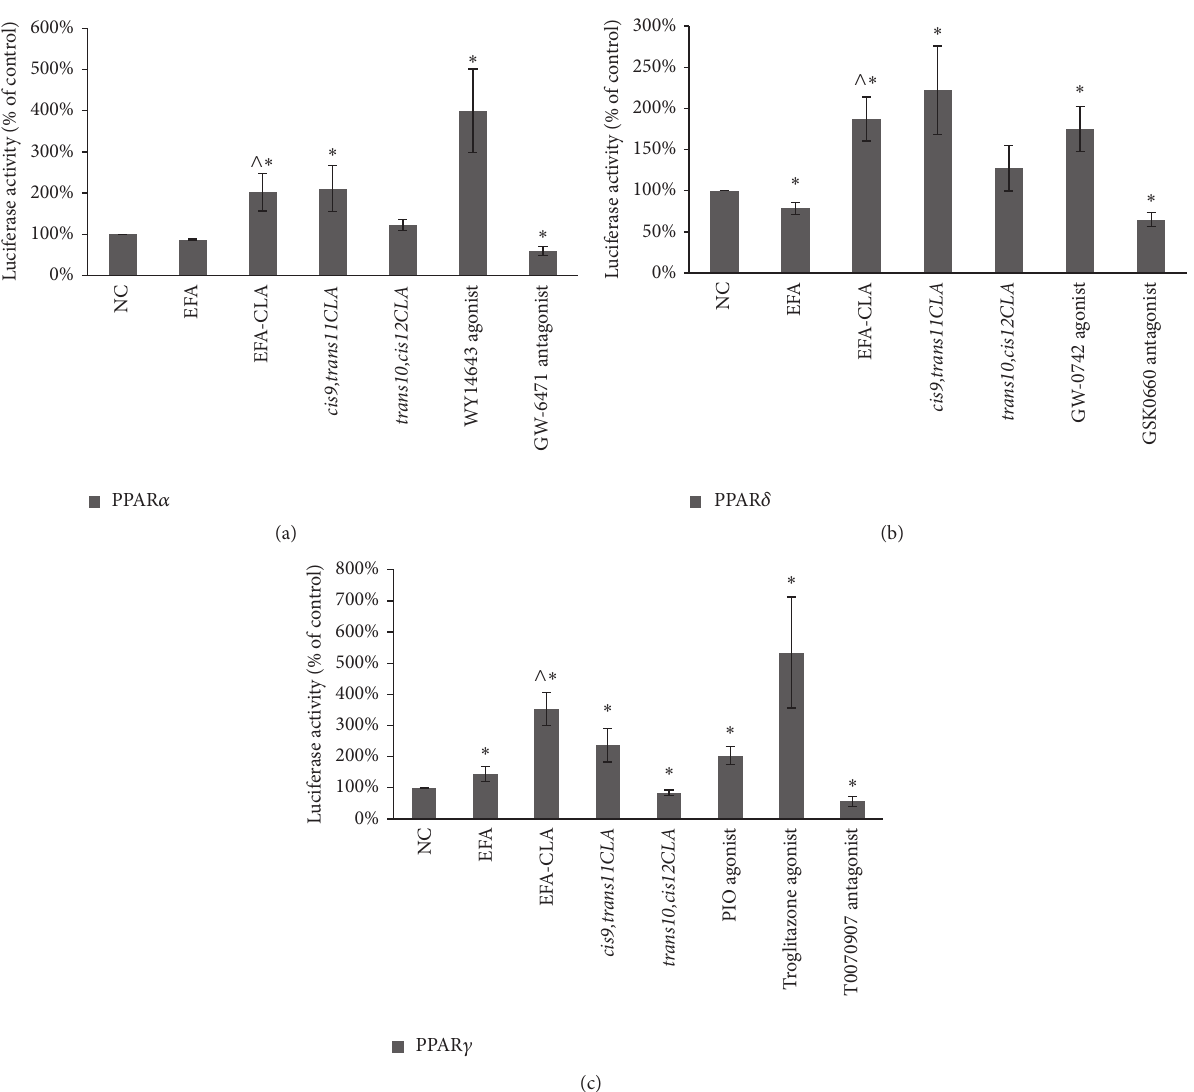
Figure 3: Effect of EFA-CLA on the activity of (a) PPAR 𝛼 , (b) PPAR 𝛿 , and (c) PPAR 𝛾 based on measured luciferase activity in dual-luciferase assay. Values are expressed as means ± SEM for 𝑁 ≥ 12 , standardized to control (NC) as 100 % . Statistical significance was based on 𝑡 -test ; ∗ 𝑝 < 0.05 versus NC or ∧ 𝑝 < 0.05 versus EFA .